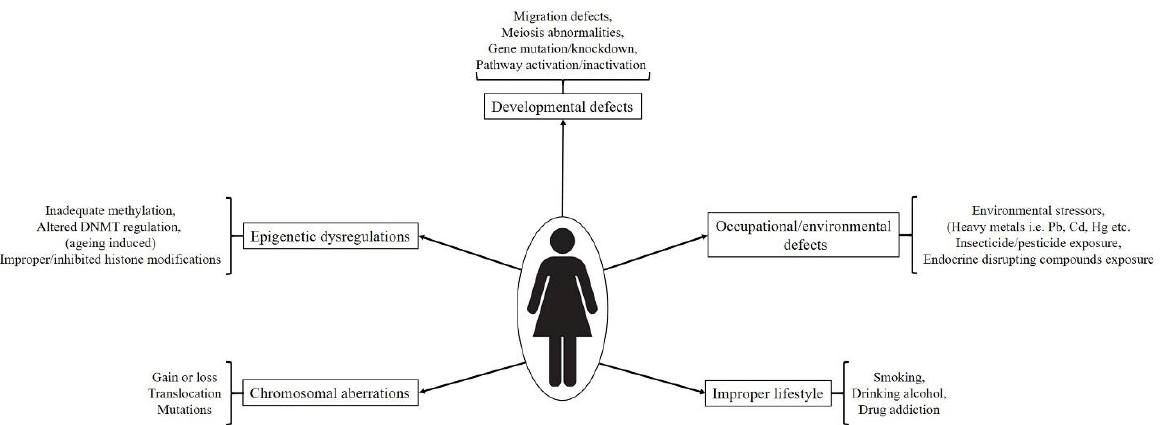
Figure 3. Diagrammatical representation of factors affecting germ cell development and their functionality. All germ cell developmental stages are affected by a number of factors including mutations, chromosomal abnormalities, improper lifestyles, epigenetic dysregulations, environmental toxicants etc. Which ultimately leads to functional impairment followed by disease development. Abbreviation- Pb: Lead; Cd: Cadmium; Hg: Mercury; DNMT: DNA methyltransferase).